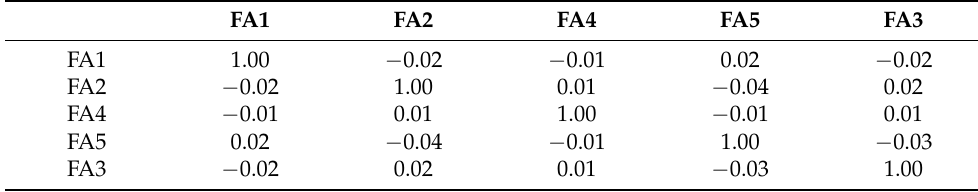
Table 7. Correlations of extracted factors